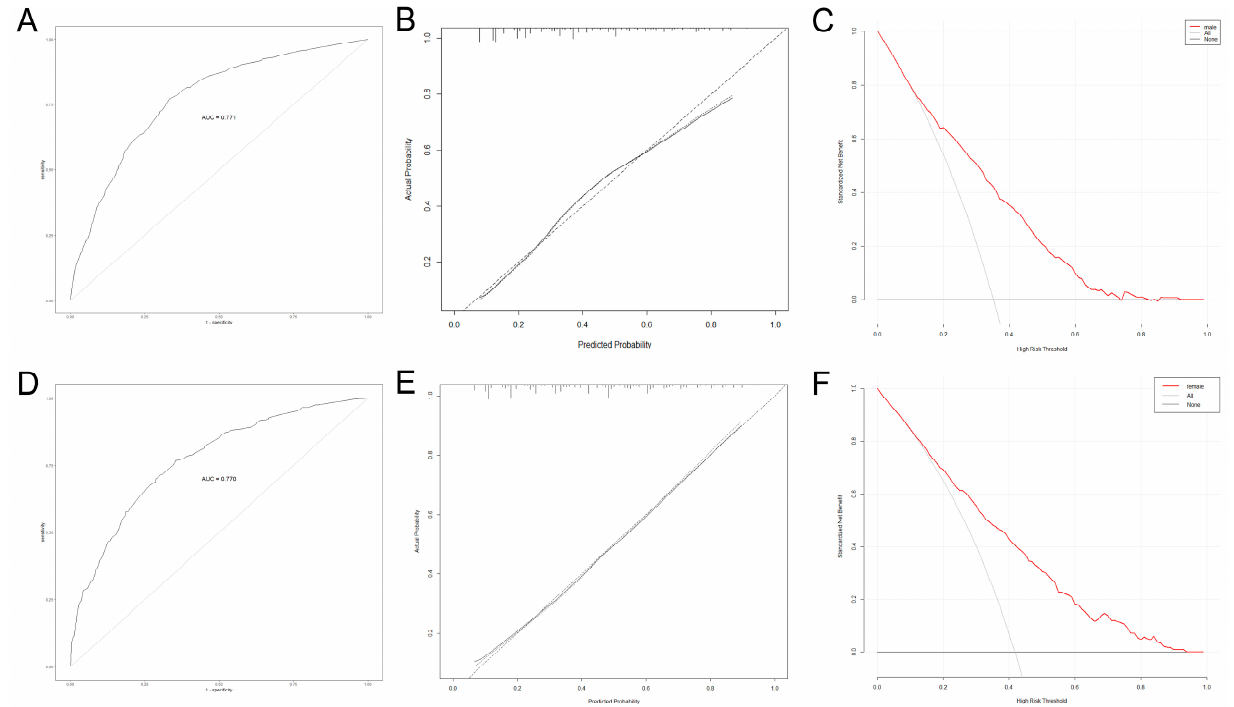
Figure 3. Internal validation and evaluation of nomogram models (the ROC curve ( A ), calibration curve ( B ), and decision curve ( C ) for males; the ROC curve ( D ), calibration curve ( E ), and decision curve ( F ) for females). (IBD: inflammatory bowel disease; UC: ulcerative colitis; CD: Crohn’s disease; ROC: receiver operating characteristic).